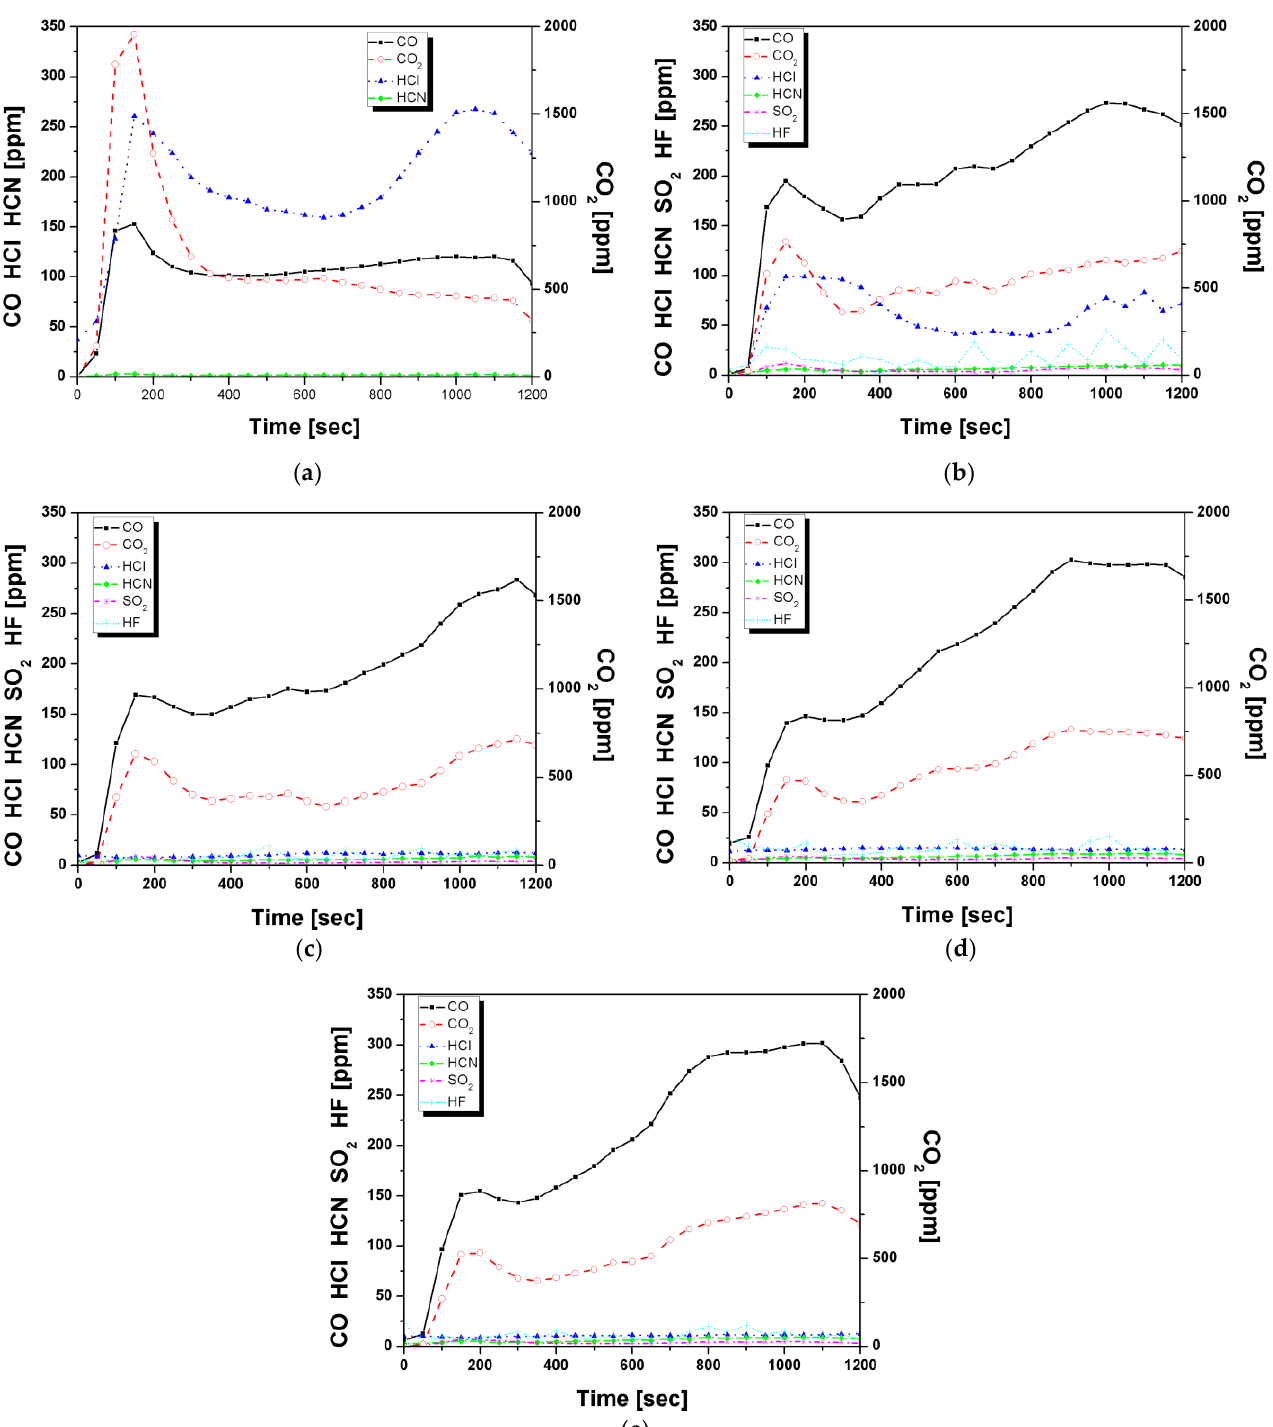
Figure 9. Time series combustion gas emissions of ( a ) non-aged cable; ( b ) 10 year accelerated aged cable; ( c ) 20 year accelerated aged cable; ( d ) 30 year accelerated aged cable; ( e ) 40 year accelerated aged cable.